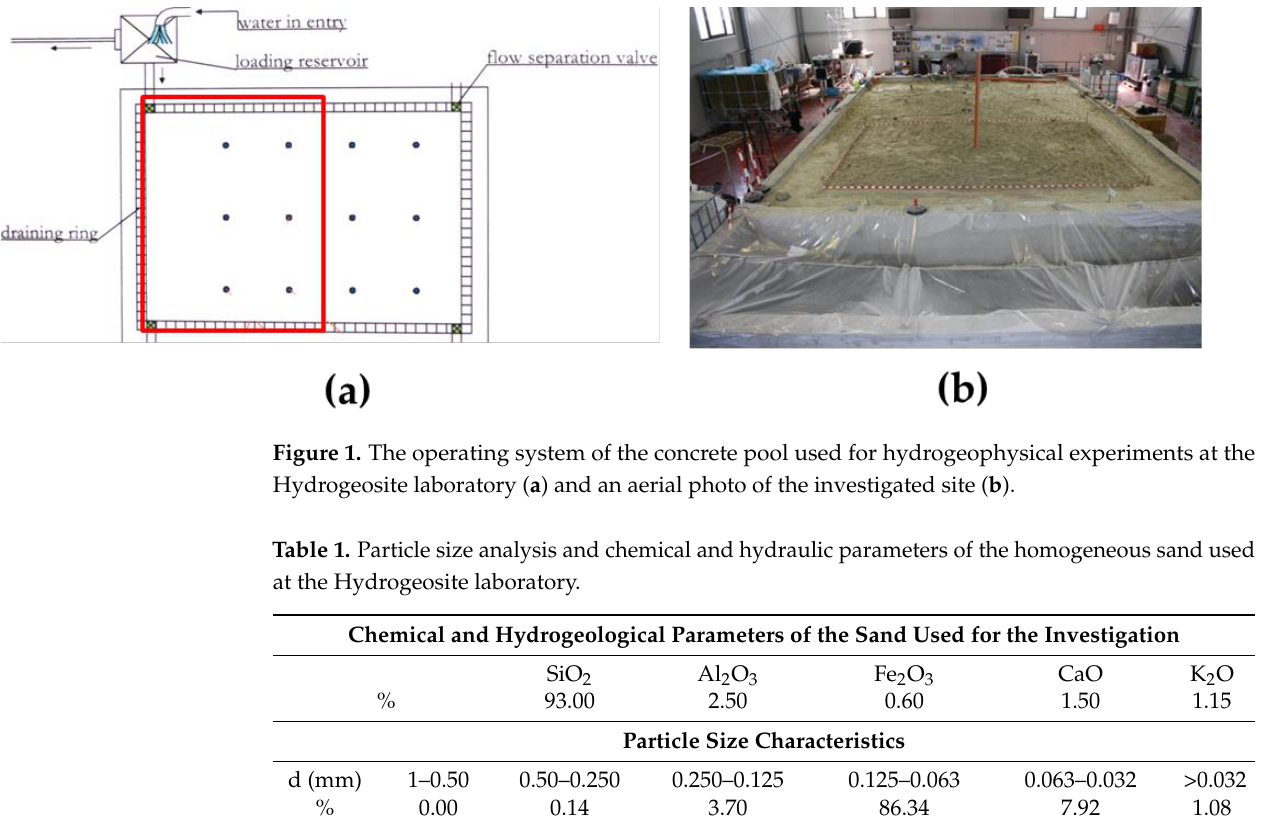
until a depth of about 1.50 m from the original ground surface.